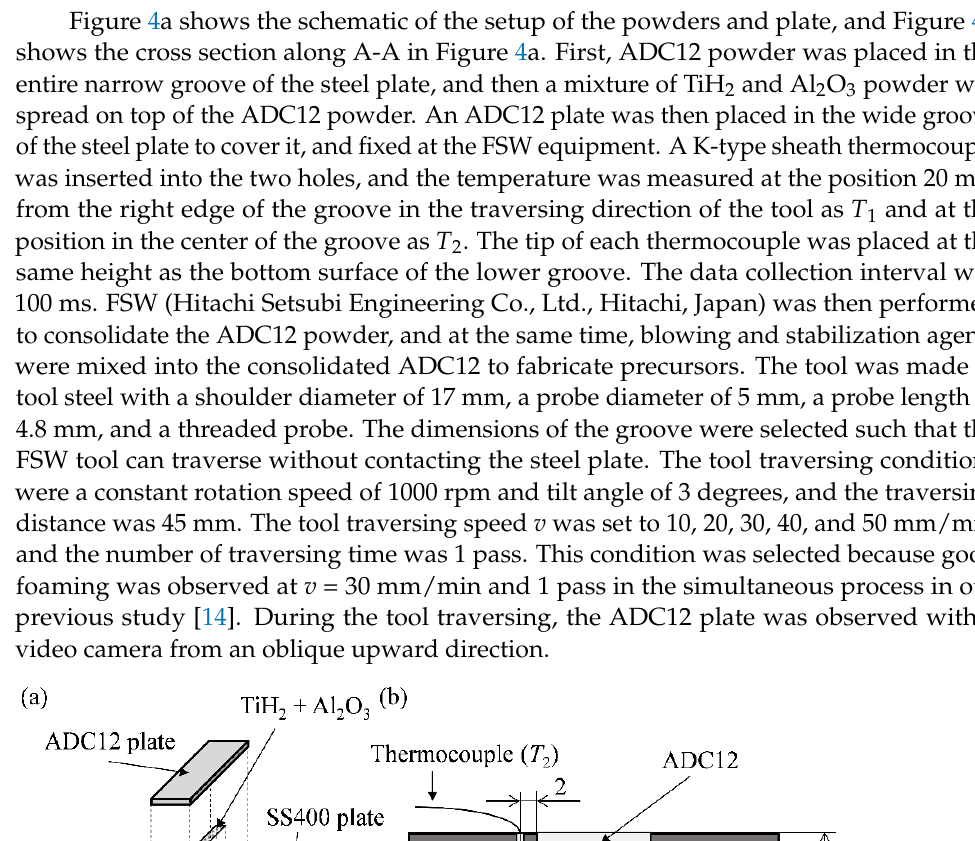
Figure 3. SEM image of ADC12 powder.